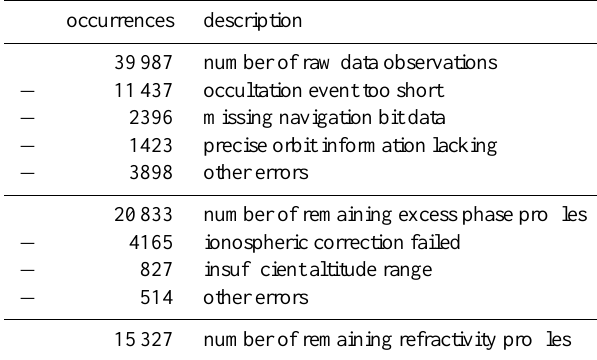
Occultation events statistics for 39987 raw observa- tions recorded between 24 July and 17 November 2008. 39987 − 20833=19154 events are removed in the first processing stage (derivation of excess phase paths from IGOR raw data), another 20833 − 15327=5506 events are flagged as deficient in the sec- ond processing stage (derivation of bending angle and refractivity profiles from excess phase